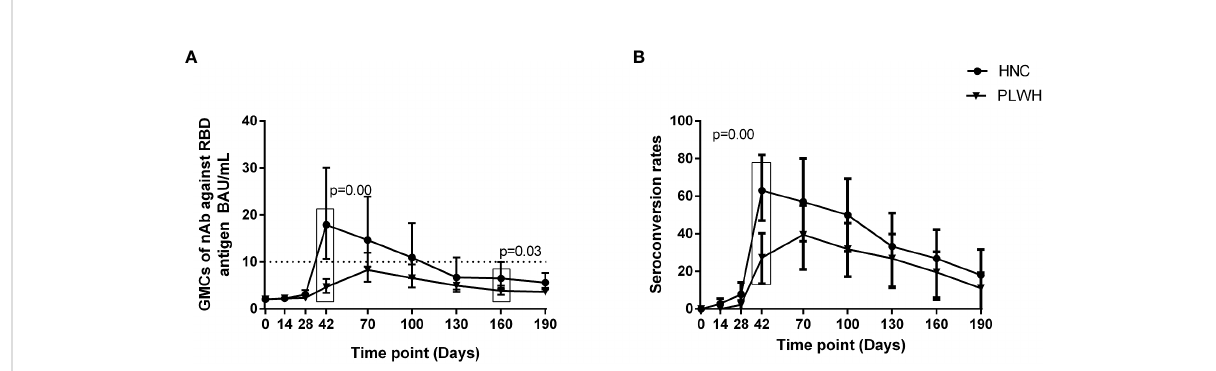
FIGURE 1 Neutralizing antibody responses to vaccination with inactivated COVID-19 vaccine among PLWH and HNC. Titers (A) and seroconversion rates (B) of Neutralizing antibody against RBD antigen at days 0-190 after vaccination. The threshold for a positive response is shown by the hashed line at 10 BAU/mL. Data points are medians (error bars represent 95% CI). P value calculated using Mann – Whitney U test (A) or Fisher ’ s exact test (B)